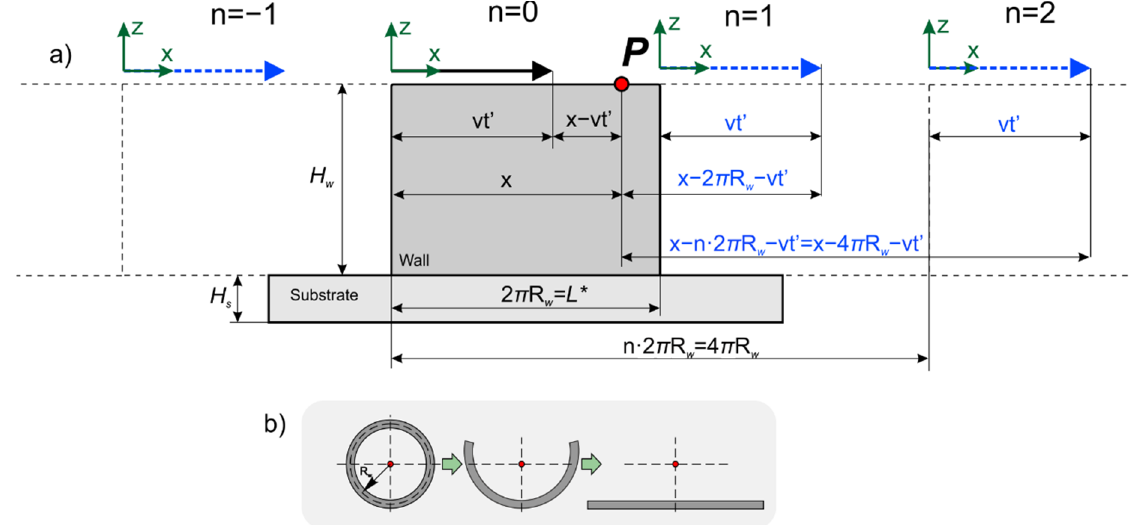
Figure 3. Scheme for taking into account the limited size of a closed wall along the length: ( a ) scheme of introducing imaginary sources; ( b ) scheme of unwrapping of a closed wall (cylindrical wall).